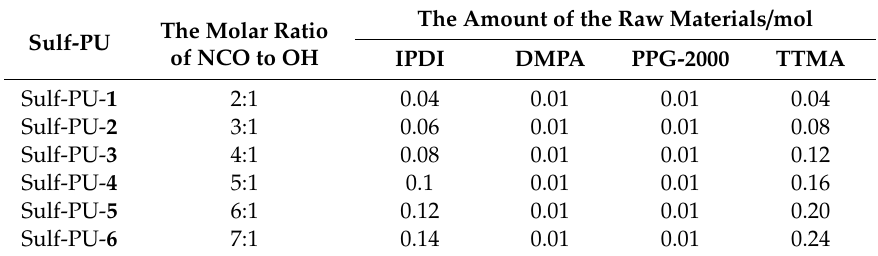
Scheme 1. The ideal diagram for the synthesis of Sulf-PU. Scheme 1 The ideal diagram for the synthesis of Sulf-PU. Table 2. The feed ratios for the preparation of sulfhydryl-terminated polyurethanes (Sulf-PUs).